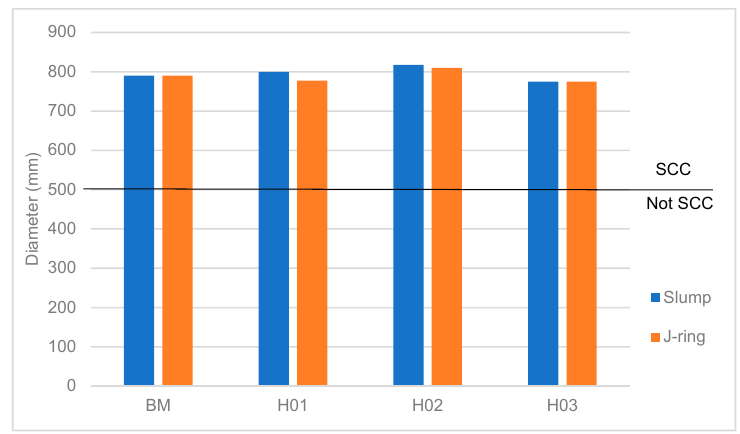
Figure 15. Results of the J-Ring flow and slump flow for hybrid SCC samples.